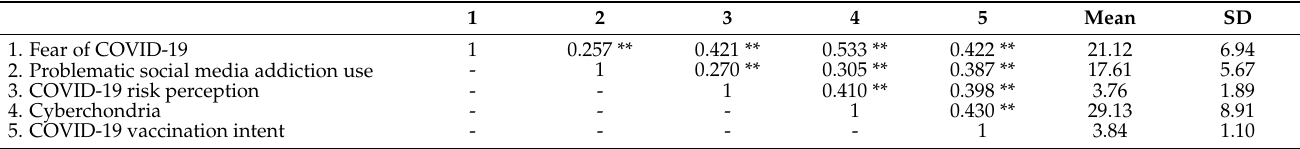
Table 2. Correlations between study